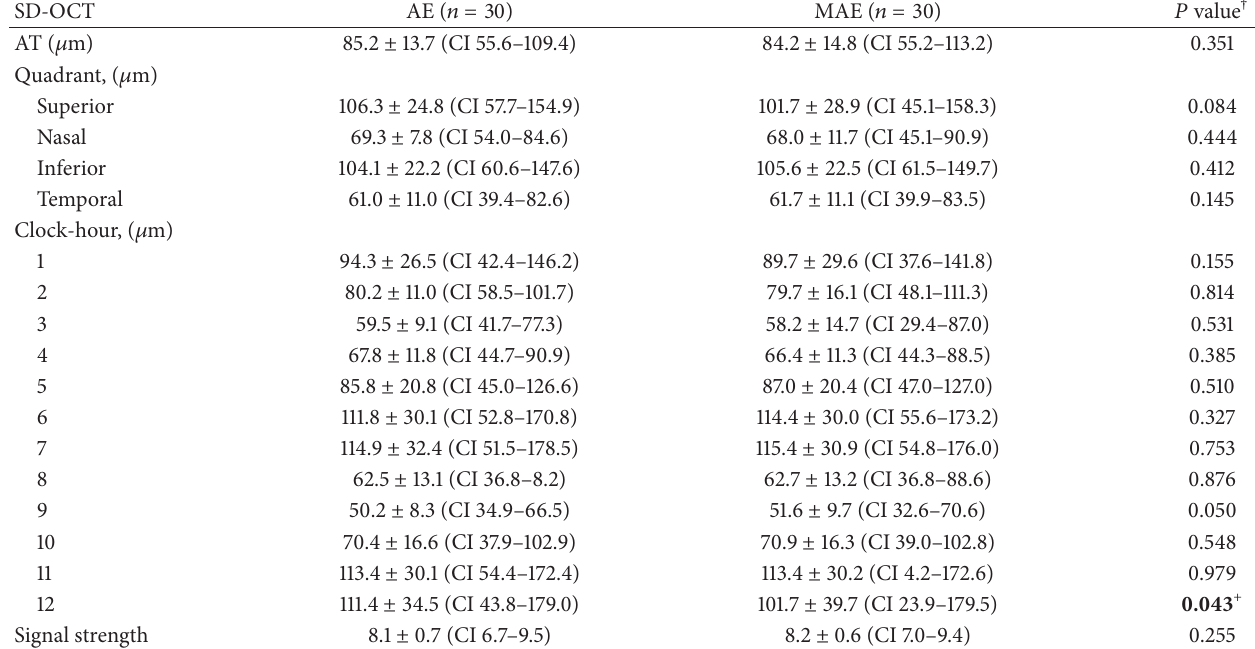
Table 3: Comparison of mean ± standard deviation (95% confidence interval) SD-OCT parameters between eyes with and without misalignments in the superior area (sectors 1 and